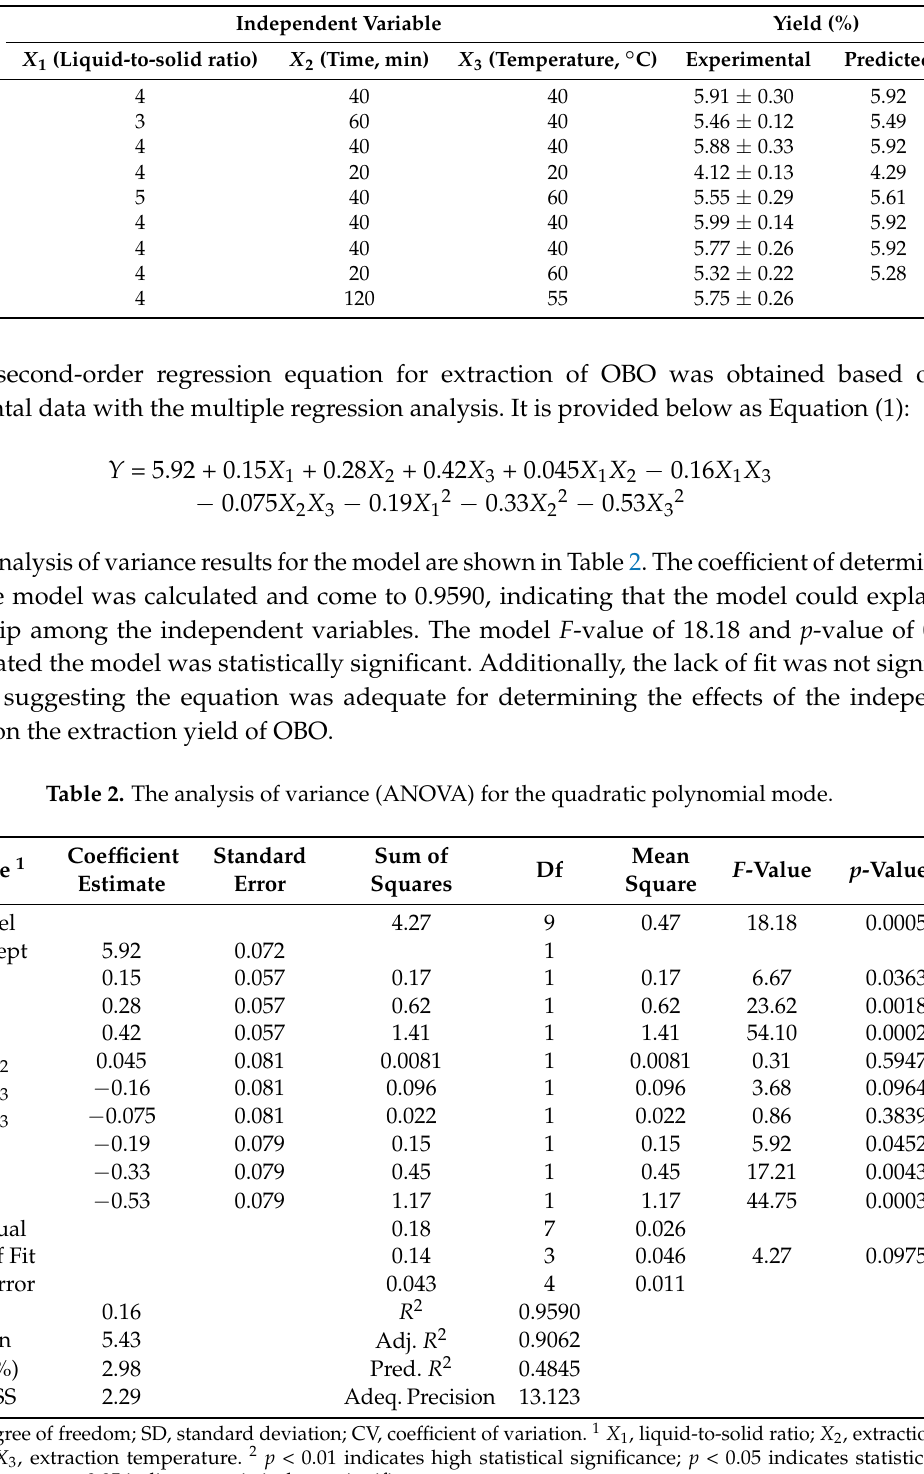
The ANOVA of the linear, quadratic and interaction terms of the model are shown in Table 2 as well. The significance of each regression coefficient was evaluated using F -value and p -value. Specifically, two linear ( X 2 and X 3 ) and two quadratics ( X 22 and X 32 ) were highly